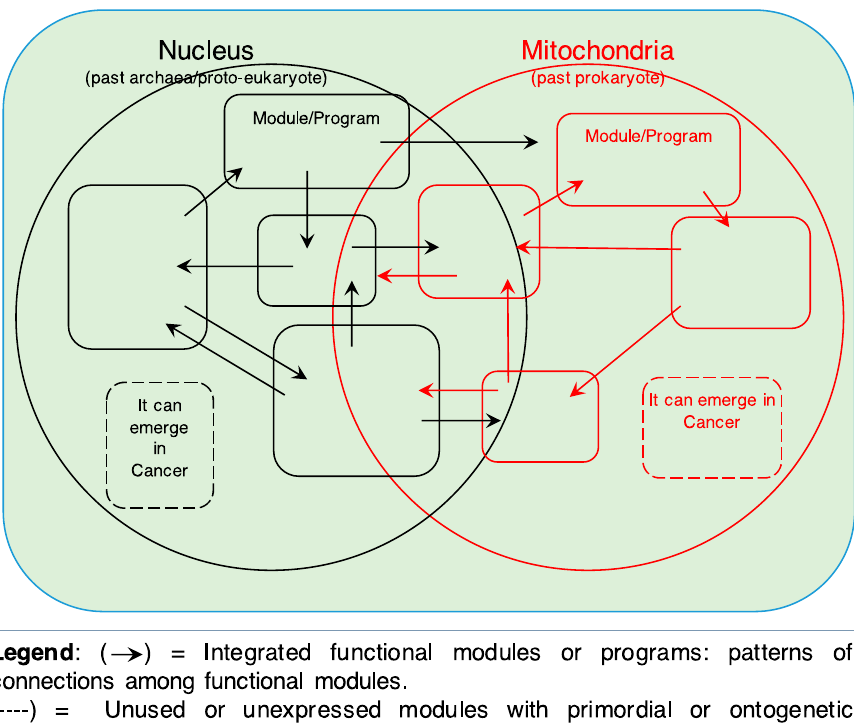
Figure 2. Both informational (past archaea/proto-eukaryote) and energy/mitochondrial (past prokaryote) components should be viewed as made up of fully functional integrated modules or programs. Modules integrate information according to patterns of connections ( ) and are highly flexible. In fact, different modules can share a given component depending on the functional status of the cell (robustness of cellular networks). However, unused or unexpressed modules (dashed lines) with primordial/unicellular-like properties (or reminiscences of these properties in the functionally integrated modules) can be present in eukaryotic cells, and “emerge” during neoplastic transformation when the “uncoupling of endosymbiosis” occurs. This would confer primordial/unicellular-like properties to cancer cells (i.e., fermentative glycolysis, adaptation to anaerobicity, cell movement, etc.). These properties may reside, as an archaic memory, even in the cellular modules in current use (solid lines), unexpressed under normal conditions but re-expressed by cancer cells.